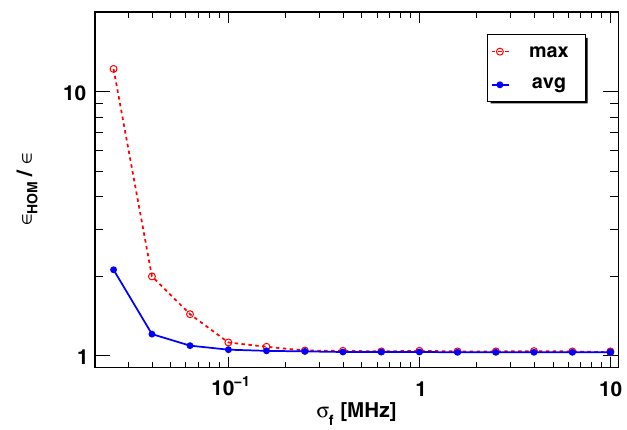
FIG. 30. Average and maximum transverse phase space in- crease dependency on the HOM frequency spread. Settings: N ¼ 100 , see Table IX.